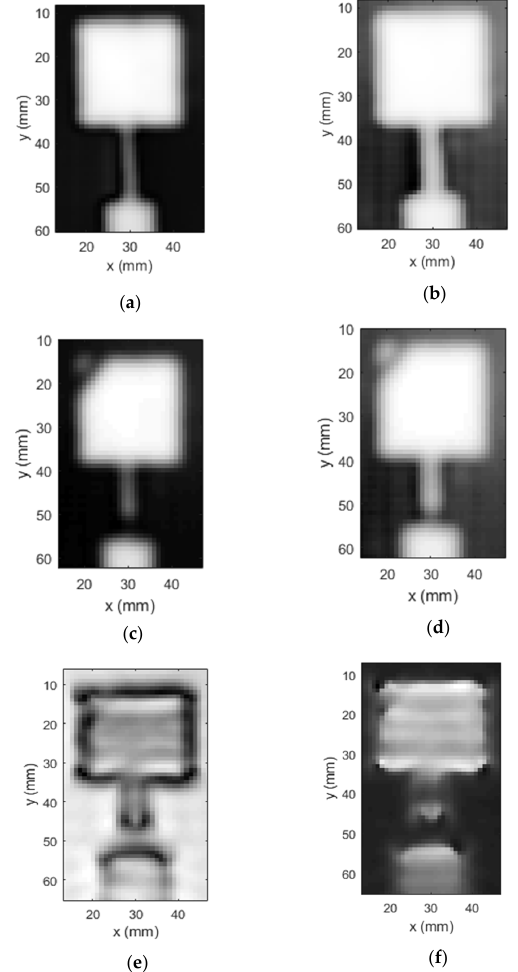
Figure 11. Magnitude and phase images of the ( a , b ) healthy and ( c , d ) damaged C-band patch antenna fabricated using metal mesh, produced by the UHF probe, and ( e , f ) damaged patch produced by K-band rectangular aperture probe.